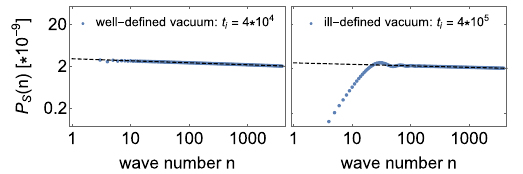
Fig. 7 Comparison between the primordial power spectra of scalar modes from a well-defined (left) and ill-defined (right) Bunch–Davies vacuum. The calculation is performed for the quadratic potential with IC {− 0 . 99 , + 1 }